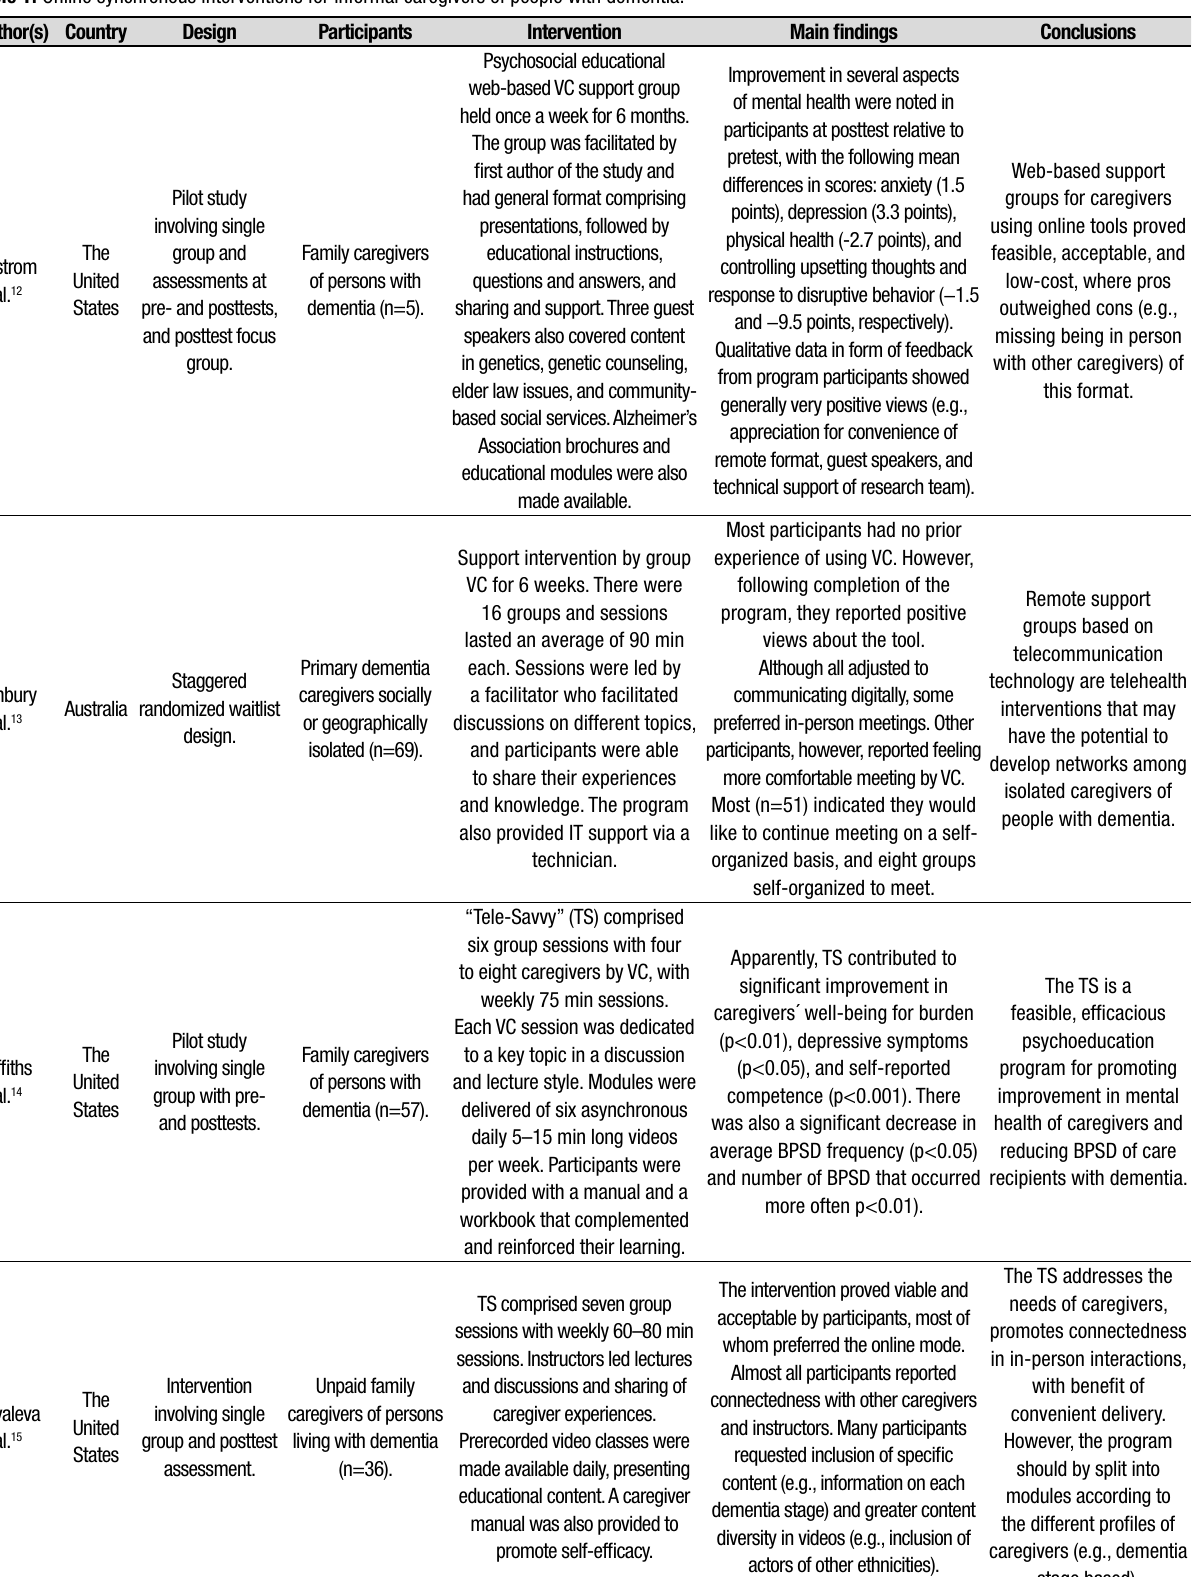
Table 1. Online synchronous interventions for informal caregivers of people with